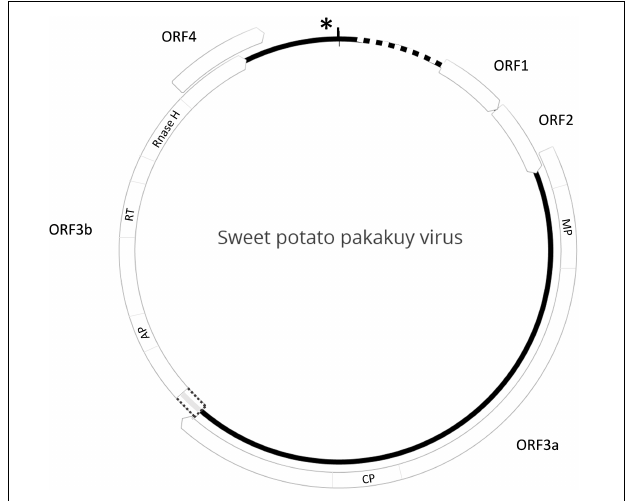
FIGURE 1 | Genome structure of SPPV. Diagram depicting the genome structure of sweet potato pakakuy virus (SPPV). Circle indicates the genome with box arrows indicating the locations of predicted ORFs and numbered in order of occurrence. The dotted box between ORF3a and 3b indicates a region of uninterrupted ORF prior to the ORF 3b start codon that could serve as a potential read-through domain from ORF 3a. Protein domains encoded by ORFs are indicated inside the box arrows where known: MP, movement protein; CP, coat protein; AP, aspartyl protease; RT, reverse transcriptase; RNaseH, RNase H domain. Star and vertical black line indicate the location of the tRNA-met like region and short stem-loop structure, respectively, whereas the dotted line indicates location of a predicted leader